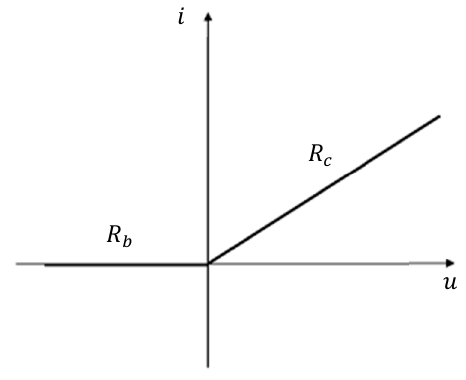
Figure 2. Piecewise linearized characteristic of the diode.